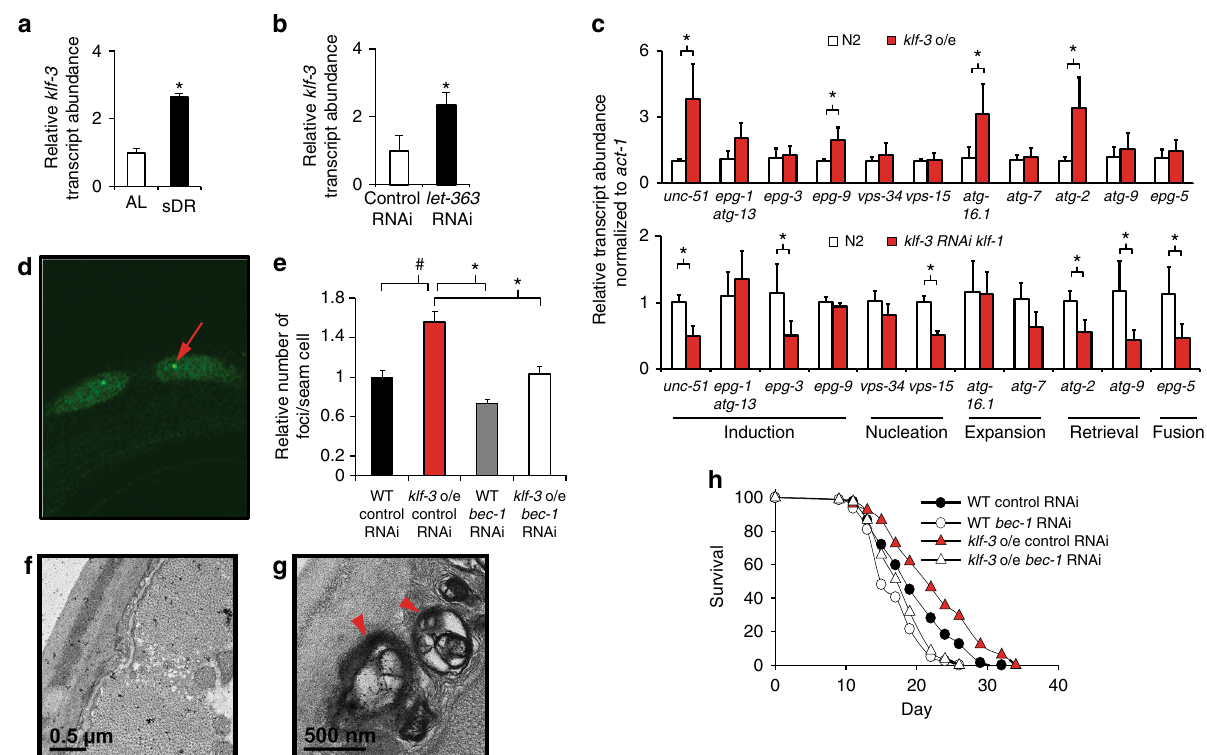
Fig. 3 KLF-mediated lifespan extension is dependent on autophagy . Klf-3 transcript levels in wild-type animals subjected to 2 days of chronic dietary restriction (sDR, OP50 diluted to 10 8 cfu/ml) ( a ) or inhibition of TOR signaling by RNAi against let-363 ( b ) starting from day 1 of adulthood. All lines were raised and maintained at 20 °C. * P -value < 0.05 by Student ’ s T -test, N = 3 biological replicates. c qPCR analysis of a panel of autophagy-related genes in day 1 klf-3 o/e and loss of function of both klf-3 and klf-1 animals compared to wild type. Double loss of function of klf-3 and klf-1 was performed as described previously utilizing the klf-3(ok175) mutant and simultaneous RNAi feeding targeting klf-1 . All lines were raised and maintained at 20 °C. * P -value < 0.05 by Student ’ s T -test, N = 3 biological replicates ( d , representative picture). e Autophagy in klf-3 o/e animals as determined by numbers of GFP::LGG- 1 punctae in seam cells ( red arrow denotes GFP-positive puncta) with knockdown of bec-1 in both wild-type and klf-3 o/e animals. * P -value < 0.05, # P -value ≤ 0.1 after one-way analysis of variance followed by the Tukey ’ s post hoc test. N = 10 – 20 animals counted. ( f , wild-type representative image, g , klf-3 o/e representative image) Electron microscopy images of klf-3 o/e and wild-type animals in animals aged 9 days. Arrowheads indicate sizeable ( ≥ 500 nm) autolysosomes as recognized by single-membrane limited vacuolar structures with visible mixed cytoplasmic contents. Full images reproduced in Supplementary Fig. 11, with additional images. h Lifespan analysis of wild-type and klf-3 o/e animals fed RNAi bacteria targeting bec-1 from day 1 of adulthood. All lines were raised and maintained at 20 °C. P -value < 0.05 by Mantel – Cox log-rank tests. See also Supplementary Table 6 for details of lifespan analyses and replicate experiments. All error bars represent standard error of the mean